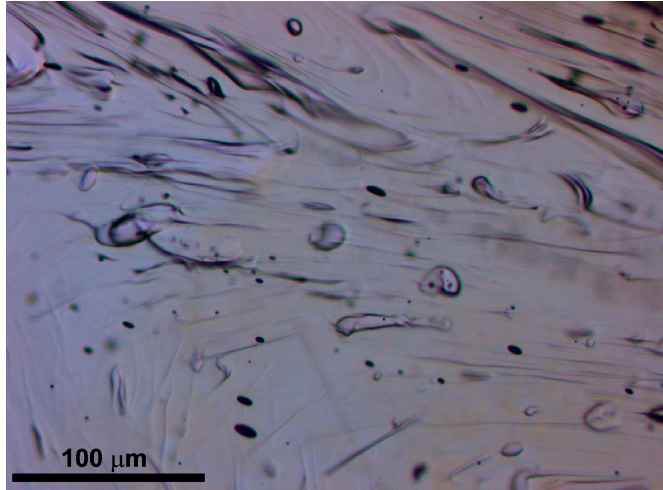
Figure 7. Transmission optical image of urengoite U1.